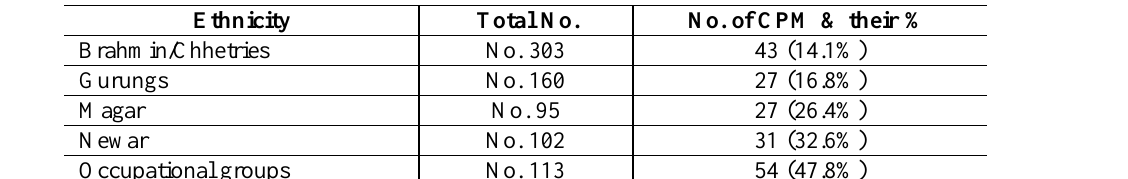
Table VII : Ethnicity and